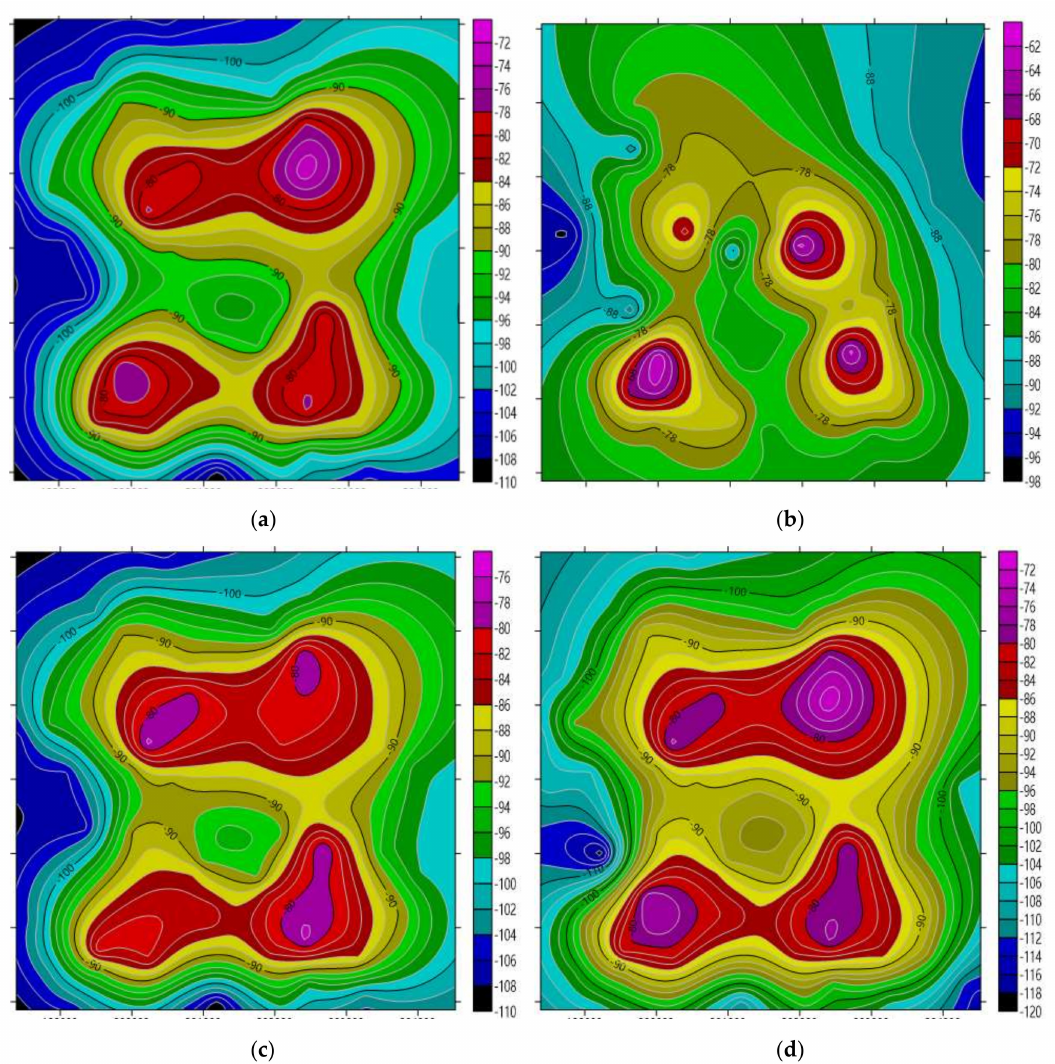
Figure 7. Coverage situation. ( a ) Kriging interpolation results; ( b ) BP interpolation results; ( c ) BP-Kriging interpolation results; ( d ) PSO-BP-Kriging interpolation results.